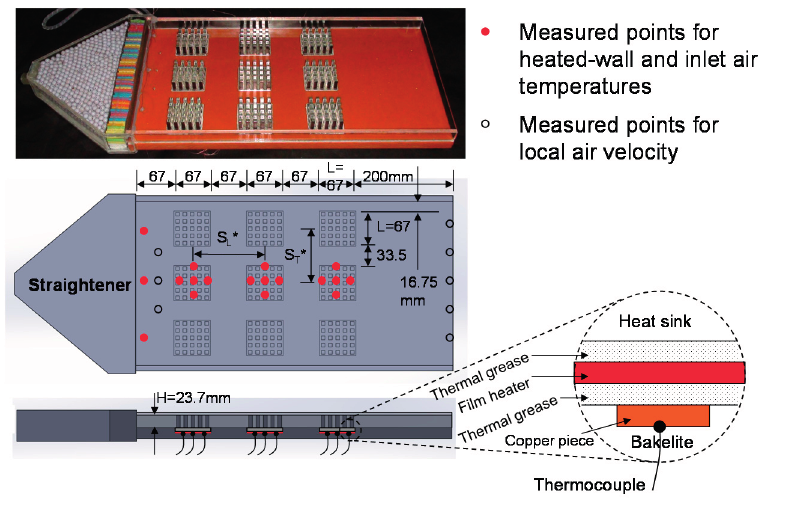
Figure 5. Configuration and dimensions of test section and positions of measured